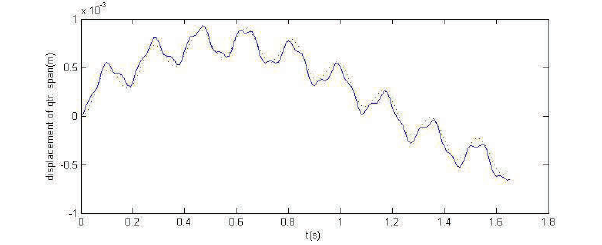
Figure 4. Displacement of qtr. Span with v=20